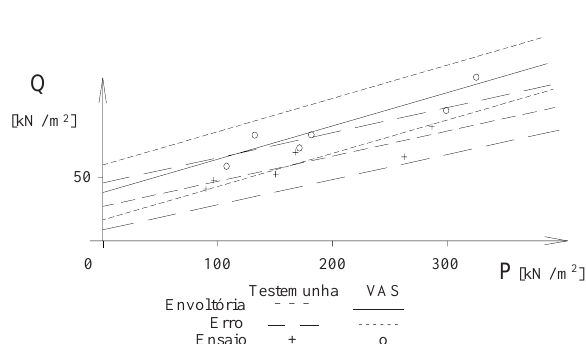
, com a região do erro associado Figura 7. Linha K f para profundidade de trabalho de 0-0,30 m.